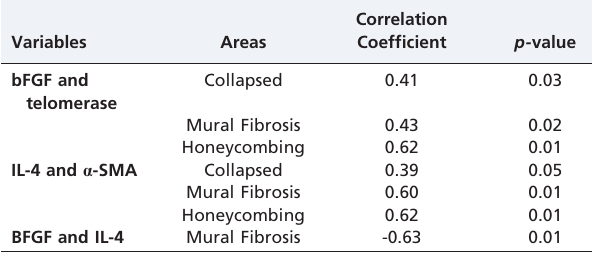
Table 2 - Significant correlations between each marker for each studied area.